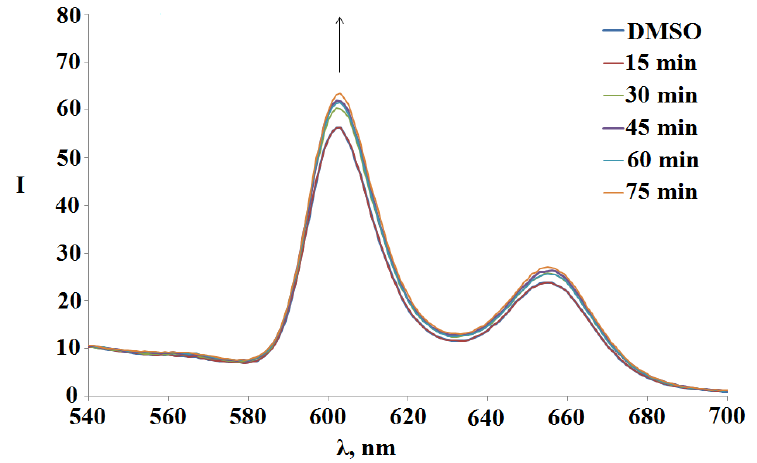
Figure 8. Changes in the fluorescence spectra of tetramer with octopamine 3 (Sn(L) 2 ) 4 (PdCl 2 ) 4 during 75 min UV photo − irradiation in DMSO.